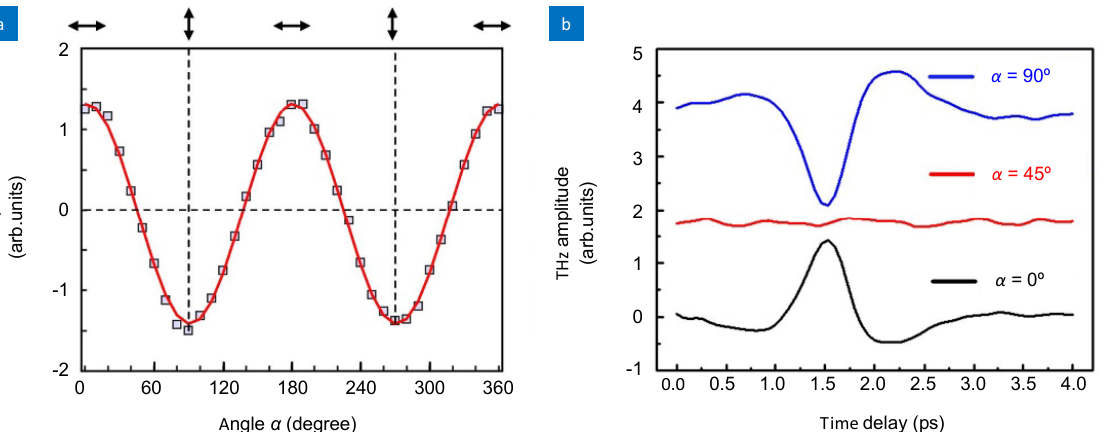
Fig. 6 | ( a ) THz amplitude as a function of the linear polarization angle α . The red solid line shows the fitting results using a sinusoidal function. ( b ) Terahertz waveforms for excitation with a linearly polarized angel at α = 0º, 45 º and 90º,